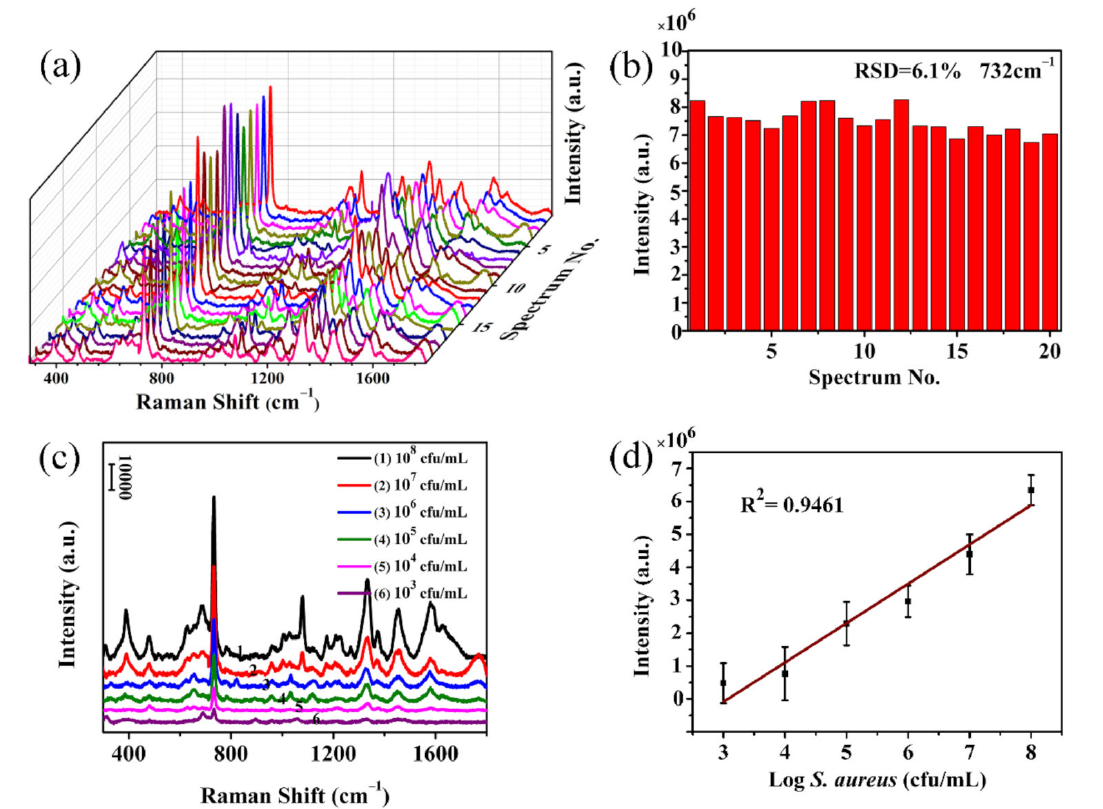
Figure 10. SERS spectra collected from 20 randomly selected points on Ag@T-A@SiO 2 @Au-20 substrate surfaces with a S. aureus concentration of 10 9 cfu / mL ( a ), intensity distributions of characteristic Raman peak at 733 cm − 1 from S. aureus SERS spectra ( b ), SERS spectra of S. aureus with di ff erent concentrations ( c ), the relationship plot between the peak intensity and the S. aureus concentration, and the fitting curve ( d